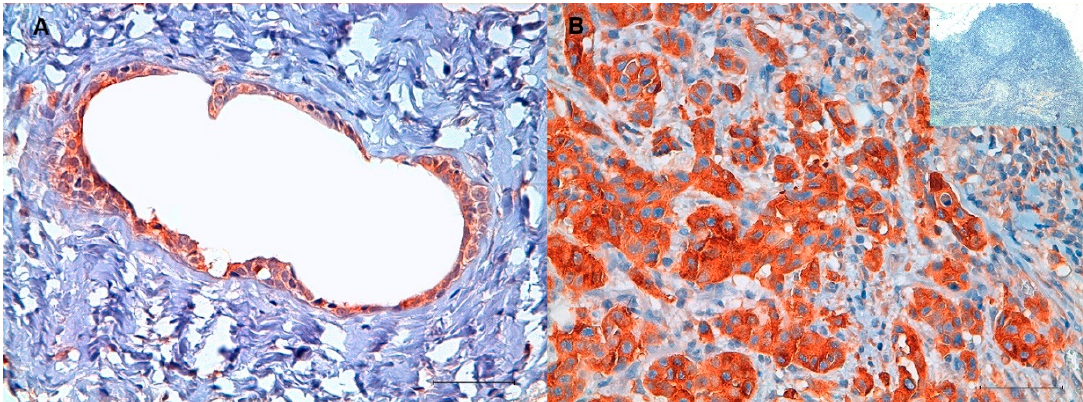
Figure 1. Immunohistochemical staining of transferrin receptor 1 (TFR-1). Immunohistochemistry was carried out on feline mammary gland. ( A ) Representative staining of healthy feline mammary gland tissue showing weakly positive cells (cyto- plasmic immunolabeling). ( B ) Representative staining of a feline mammary carcinoma with lymph node metastasis showing strong cytoplasmatic immunolabeling of neoplastic cells associated with mild positivity of endothelial and inflammatory cells, as well as fibroblasts. The inset represents a feline lymph node, used as a negative control (10 × ). The images were obtained using a 40 × objective. Immunohistochemistry TFR-1, Diaminobenzidine (DAB) chromogen. Scale bar: 50 µ